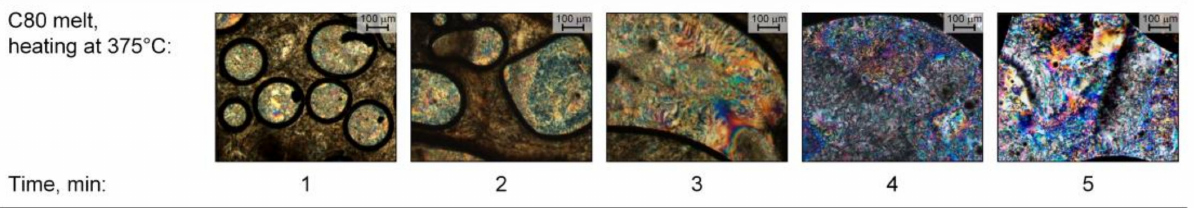
Figure 9. Evolution of the LC phase content over time for C80